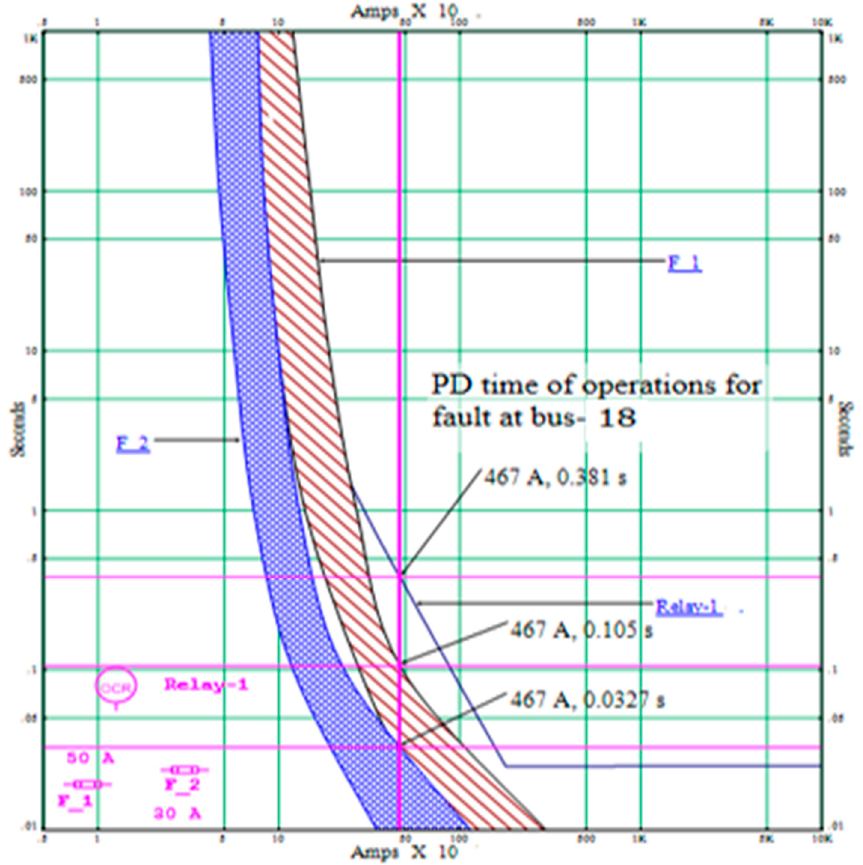
Figure 12. Log–log diagrams of the relay and downstream fuse 1 and fuse 2.